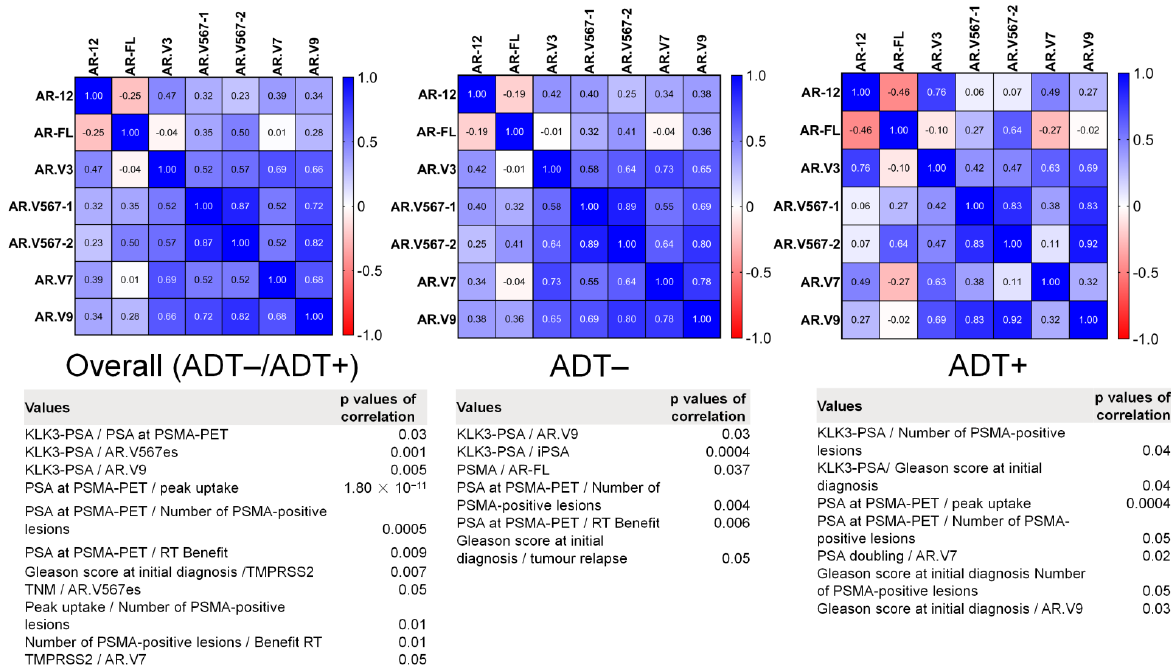
Figure 2. Landscape of investigated molecular alterations in individual CTCs and RT benefit. The overview of 43 samples with 42 CTC-positive samples in the investigated cohort is shown in the upper panel. The overall results of CTC analysis, ADT application in follow-up, and RT response are schematically summarized. The meaning of the color and number or “+/ − “ coding is as indicated. A known co-expression of AR splice variants (e.g., AR.V3 , AR.V7, and AR.V9 ) was